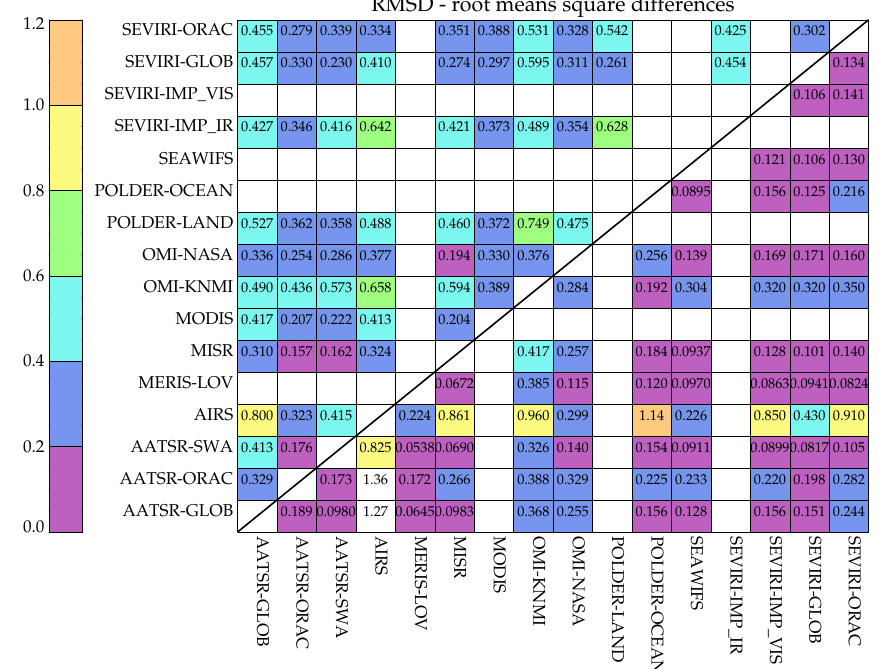
Fig. 9. Root-mean-square difference between different datasets. Values above the diagonal are for data over land, below the diagonal are over ocean.